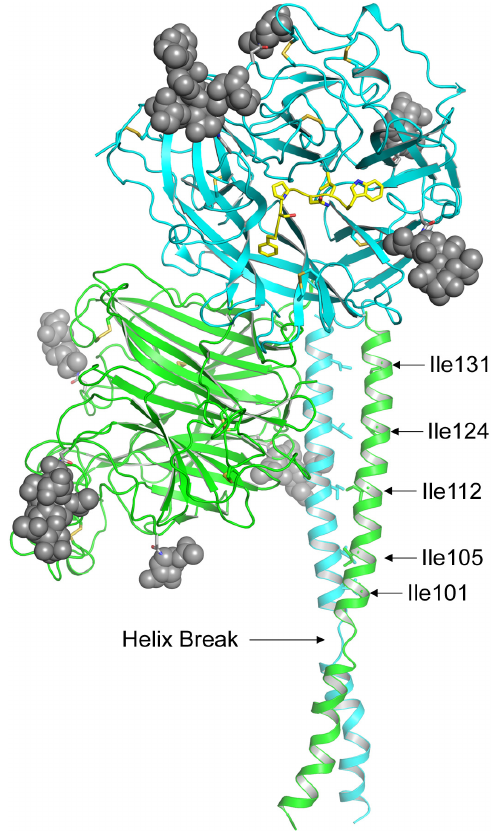
Figure 1. Model of the Hendra virus attachment G glycoprotein. The HeV-G ectodomain is shown in its dimer conformation. The secondary structure elements of the two globular head domains, colored in green and blue, are derived from the crystal structure, which also revealed the five predicted N-linked glycosylation sites (N306, N378, N417, N481 and N529) occupied by carbohydrate moieties (gray spheres) [46,47]. However, N378 was not modeled in the figure due to weak electron density. The G glycoprotein head domain folds as a six-blade β -propeller with disulfide bonds illustrated as yellow sticks. The residues of the ephrin-B2 G-H loop are shown in yellow. While the entire structure of the HeV-G stalk domain (residues 71–173) has not been determined, residues 77–136 are modeled for each monomer suggesting this region forms a discontinuous helix (Helix Break) [50]. The position of the HeV-G head dimer and stalks are oriented based on the alignment with the NDV structure and the receptor binding face of the blue monomer is facing out and the green monomer is facing left. Despite having two helical ranges, Thr-77 to Lys-95 and Thr-98 to Ser-135, the HeV-G stalk residues 98–135 appear equivalent to the HN glycoprotein stalk helix domain of the recently reported NDV structure [49]. Additionally, the Ile residues in the HeV-G stalk domain that can modulate conformational changes associated with receptor binding are indicated and are located in the alpha helical region of the HeV-G stalk domain that aligns with the NDV-HN stalk